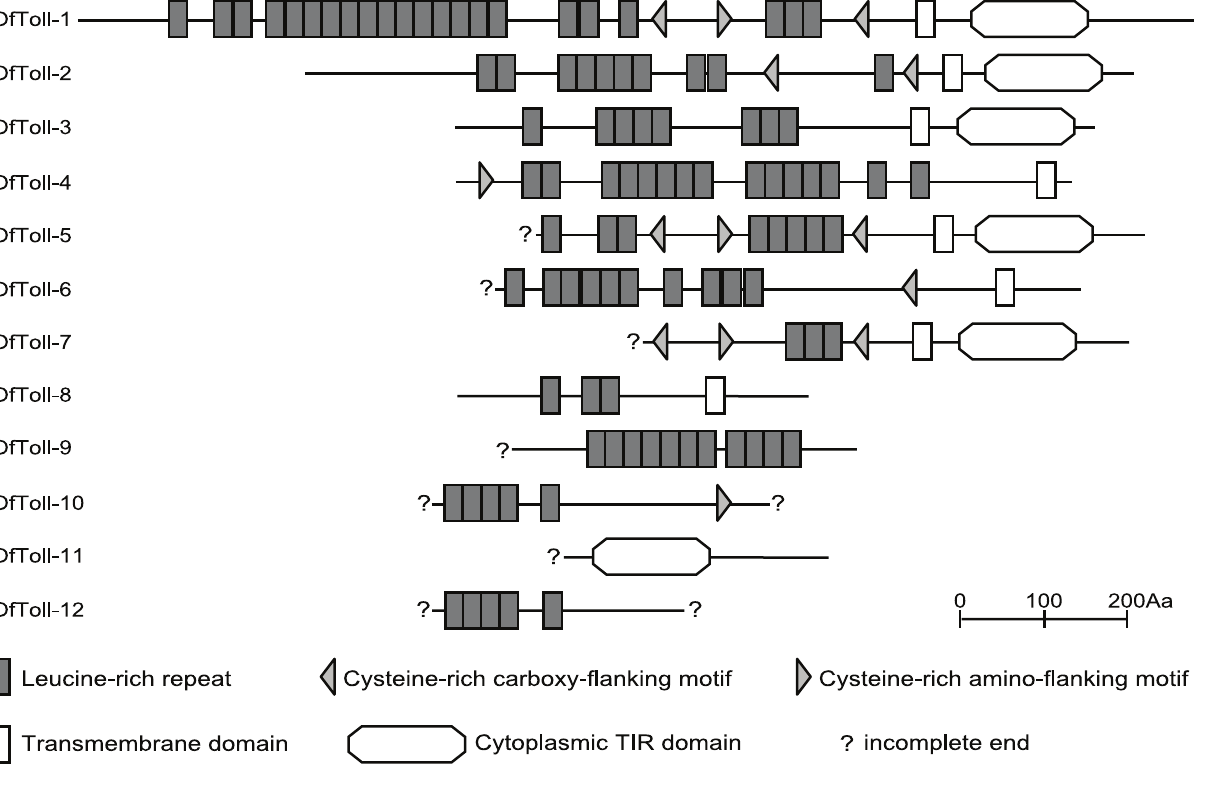
Figure 7. Schematic representation of the O.furnacalis Tolls. The domain organization was predicted using the SMART program (http://smart. embl.de/). The extracellular leucine-rich repeats are shown by small rectangles. Cysteine-rich carboxy-flanking, and amino flanking motifs are shown by left and right triangles, respectively. Putative transmembrane domains are shown by open boxes. TIR domains are represented as hexagons. Question mark means the end is incomplete.